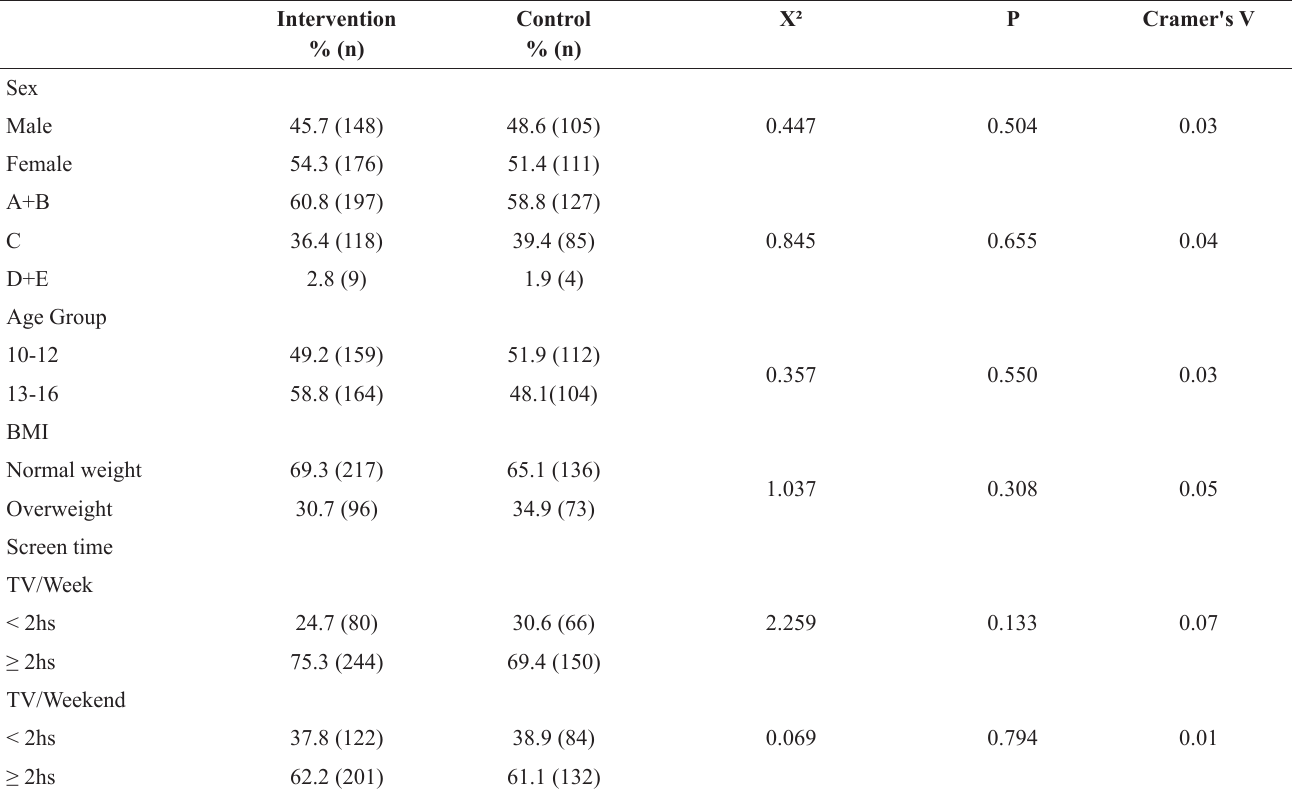
Table 1. Comparison between groups (intervention and control) at baseline. “MEXA-SE” Study, Florianópolis, SC / Brazil, 2015